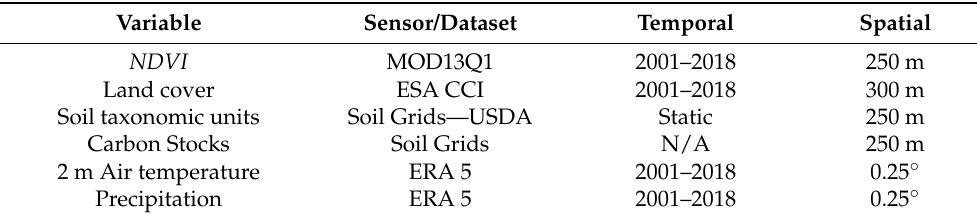
Table 1. Dataset used in this study—Variables, Sensors, temporal, and spatial resolution. Variable Sensor/Dataset